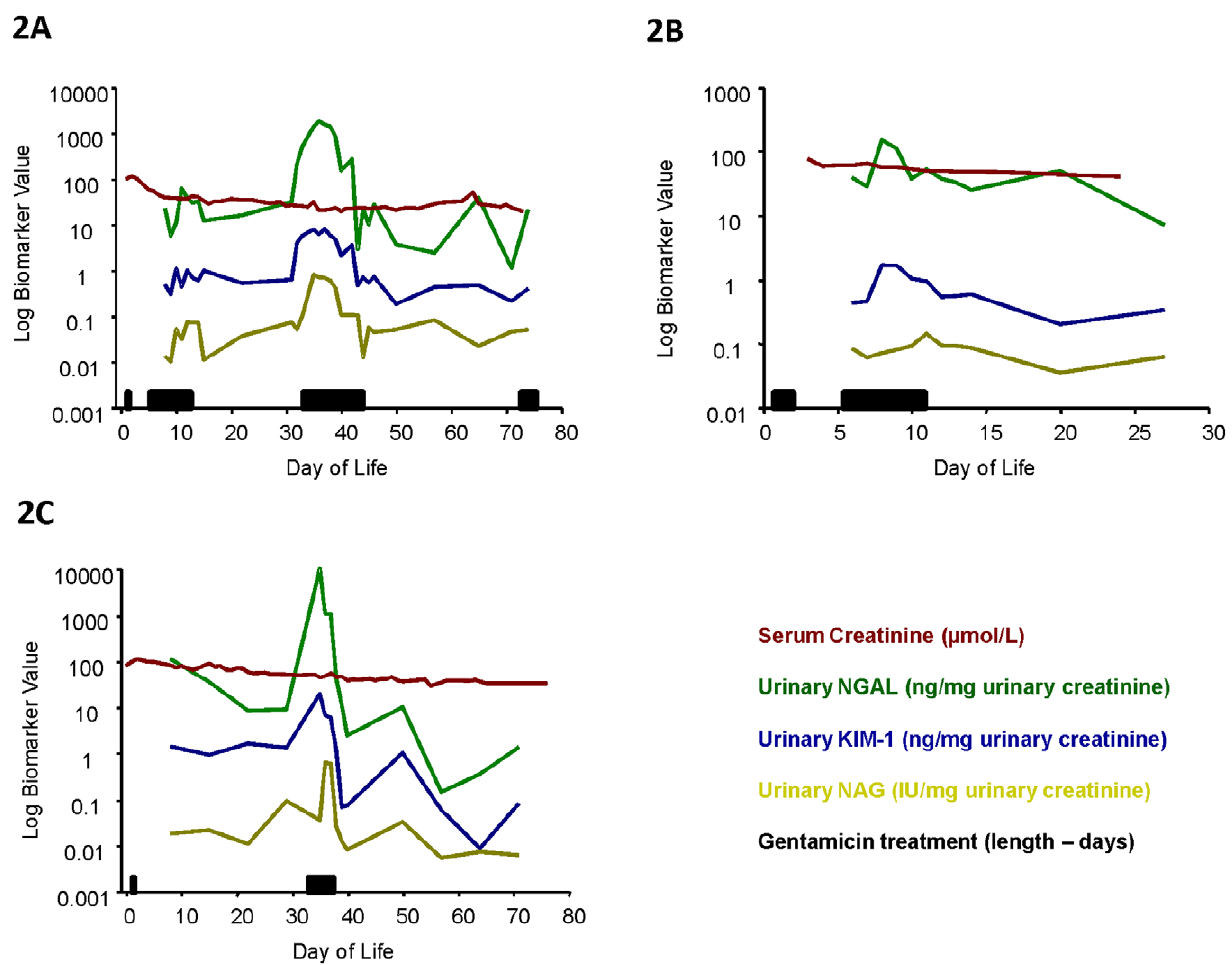
Figure 2. Longitudinal biomarker analysis of infants treated with multiple courses of gentamicin without a change in serum creatinine concentration. Representative figures demonstrating the longitudinal quantification of the biomarkers KIM-1 (blue; ng/mg. uCr), NGAL (green; ng/mg. uCr), NAG (yellow; IU/mg. uCr) and serum creatinine (red; m mol/L) for three infants treated with gentamicin (A–C). Gentamicin treatment episode and length of treatment (days) are indicated by the black horizontal bar on each figure for that individual